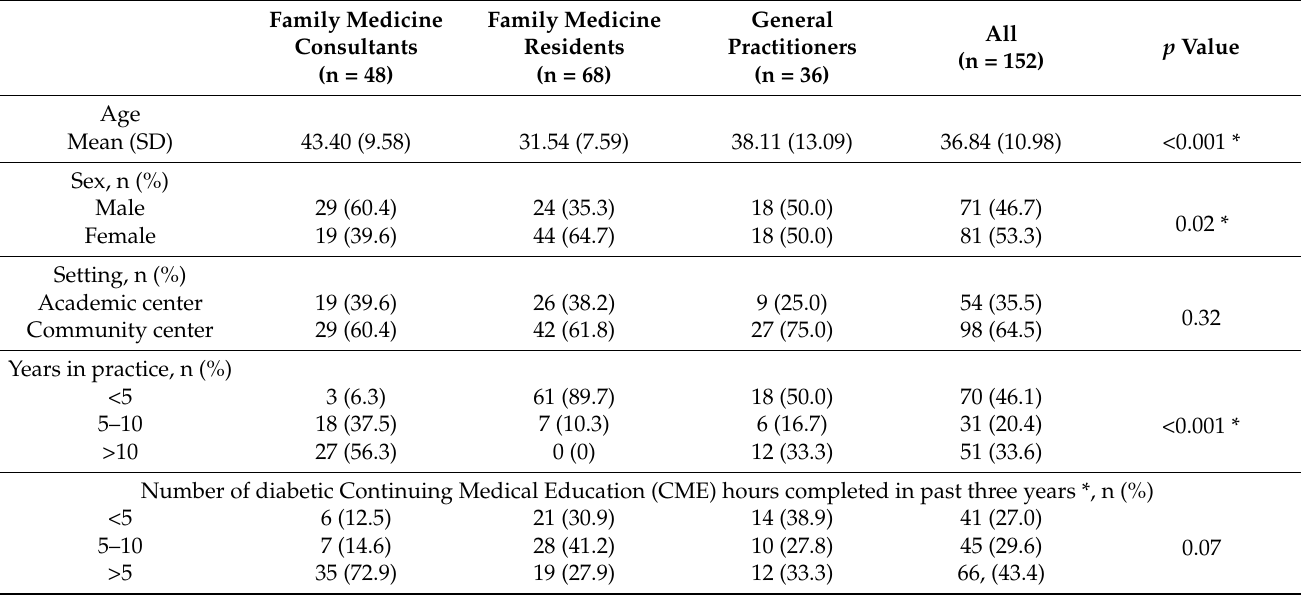
Table 1. Participants’ demographics and clinical practice characteristics (N =